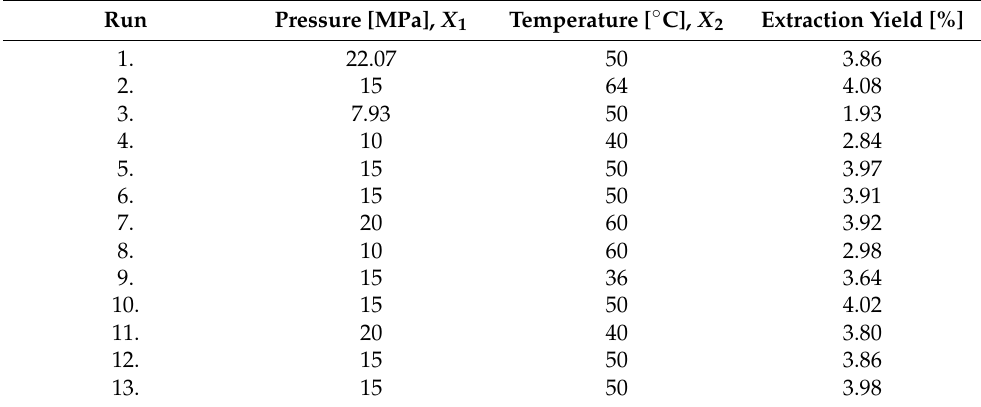
Table 1. The CCRD experimental design and results for the T. distichum needles total extraction yield